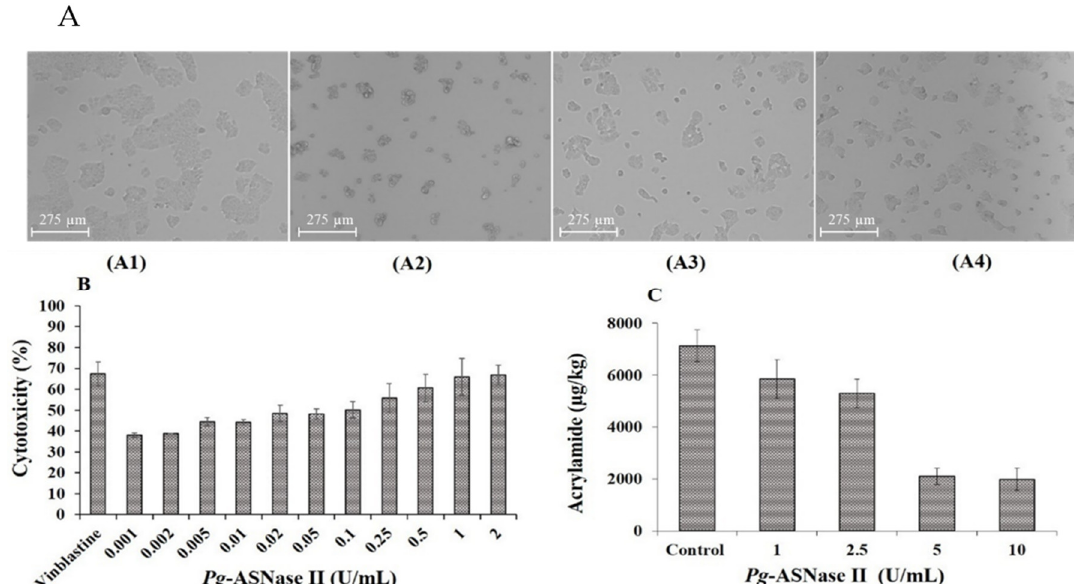
Figure 7. Exploration of the potential application of tag-free Pg -ASNase II. ( A ) Cytotoxicity against MCF-7 cells was tested using an MTT assay. ( A1 ) control, ( A2 ) vinblastine, ( A3 ) effect of asparaginase in 24 h, and ( A4 ) effect of Pg -ASNase II in 48 h. ( B ) Cytotoxic effect of purified tag-free Pg -ASNase II against MCF-7 breast cancer cell line when treated with varying enzyme concentrations. The cells were incubated for 24 h with purified enzyme, and cell viability was measured and compared with untreated cells. ( C ) Acrylamide content in fried potato chips treated with different doses of Pg -ASNase II prior to frying compared with untreated fried potato chips (control). The error bars represent the standard deviation of three experiments.